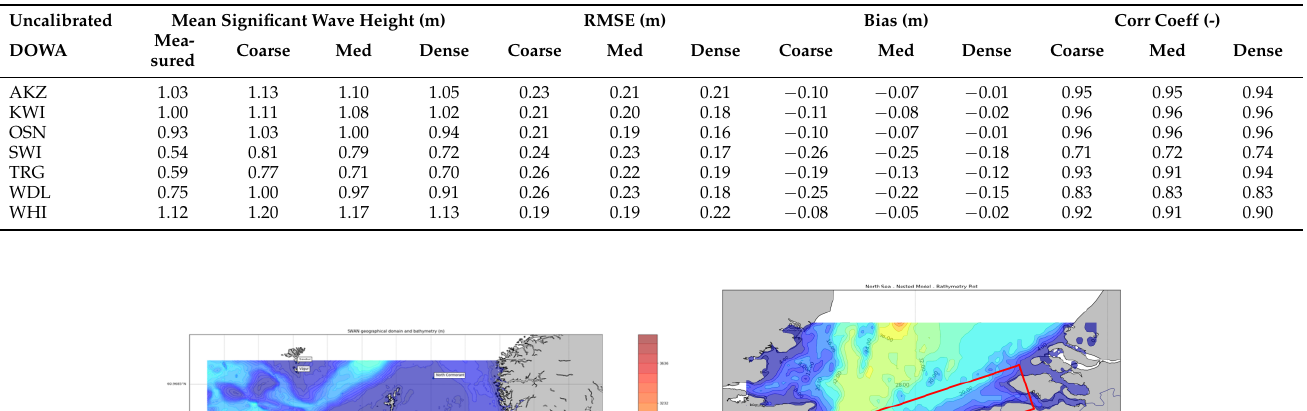
Table 14. Uncalibrated SWAN model forced by the DOWA wind database showing the mean wave heights, RMSE, Bias and correlation coefficient relative to measured data at Belgian coastal measuring stations.